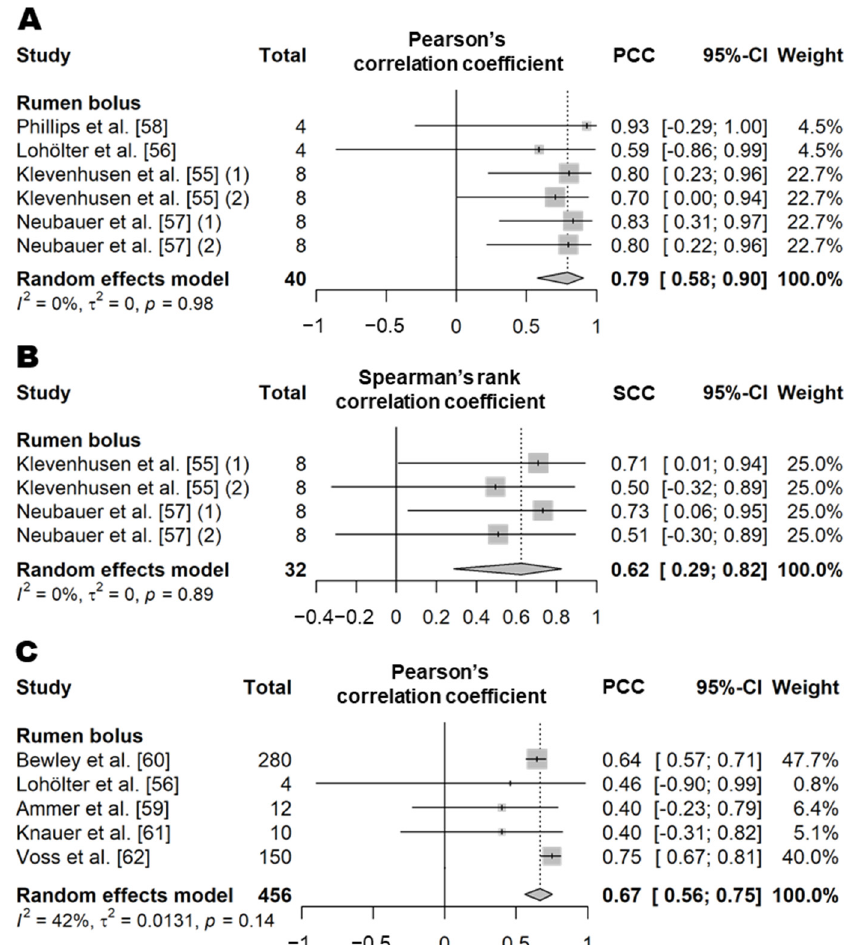
Figure 12. Forest plot of the correlation coefficient of rumen status (pH and temperature) between wearable sensors and visual observation. ( A , B ) show Pearson’s correlation coefficient and concordance correlation coefficient of rumen pH, respectively. ( C ) shows the Pearson’s correlation coefficient of rumen temperature. Numbers in parentheses indicate individual studies applying different evaluation conditions within the same article. ‘Total’ means the sample size of each study and ‘Weight’ means the weight for the mean based on the sample size.